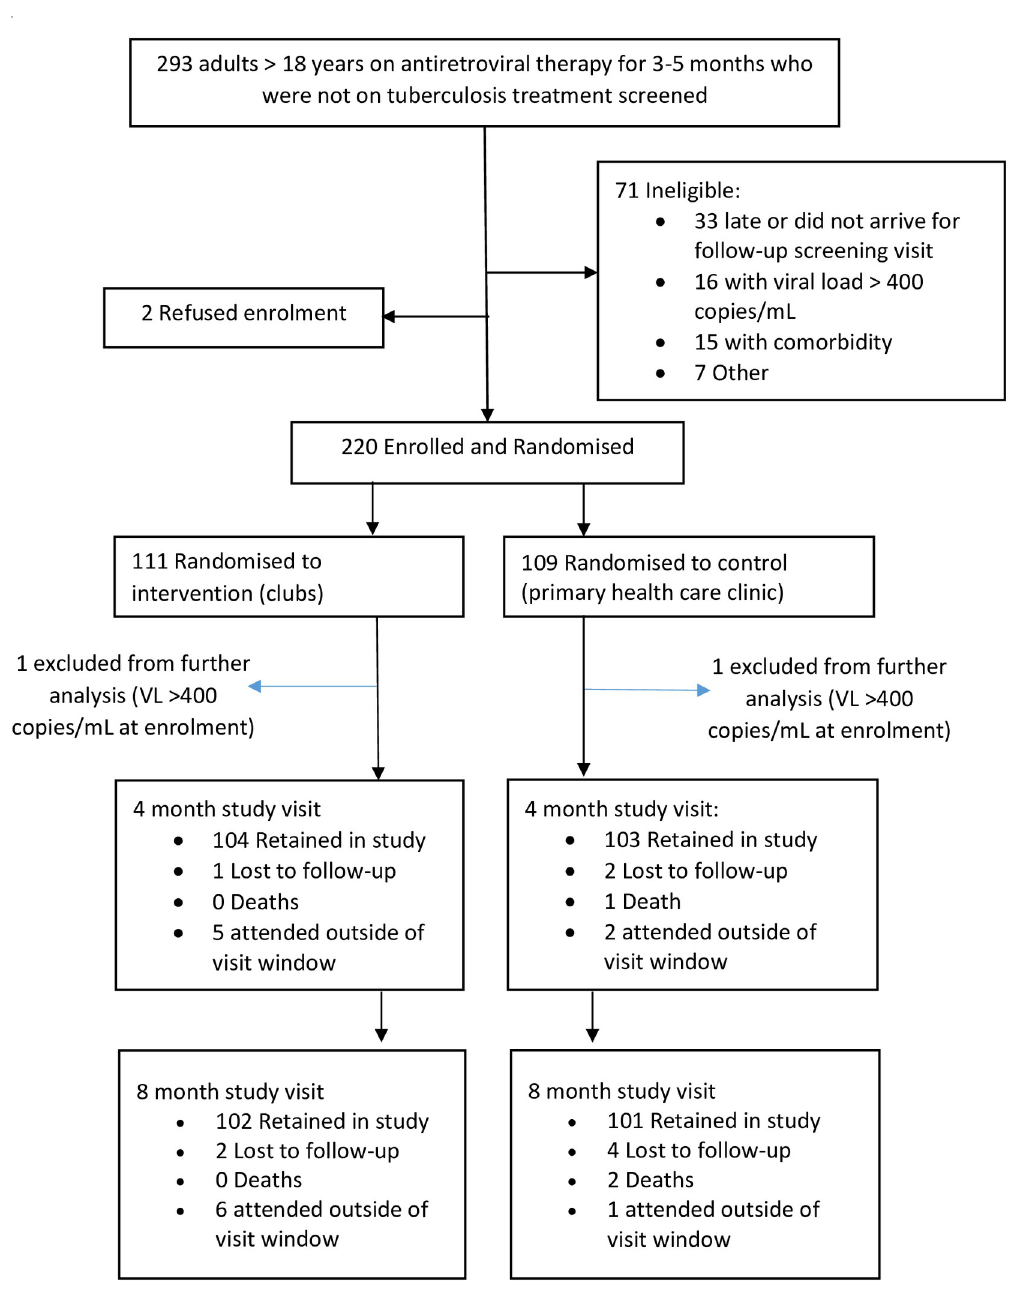
Fig 1. Study enrolment, randomisation and follow-up